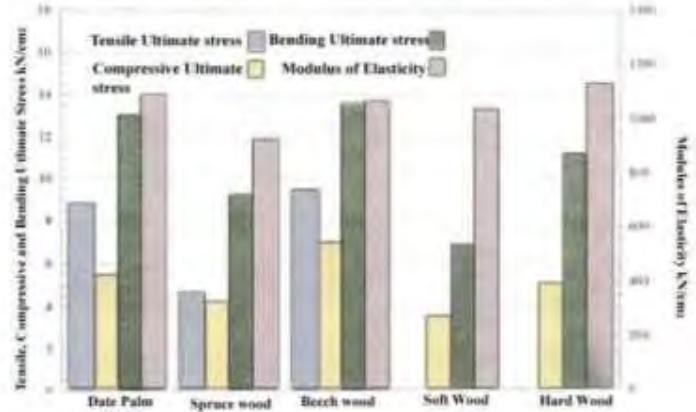
Figure 13. Comparison between the mechanical properties of Palm Rachis and imported wood and their standard values in ASTM D2555-88 (Elmously, 2001)